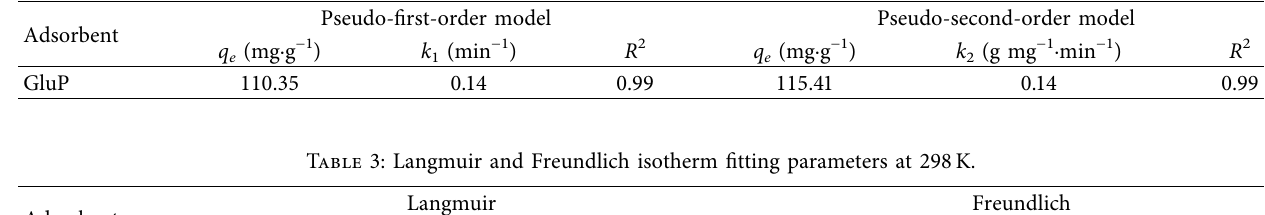
Table 2: Kinetic parameters for the adsorption of CR on GluP at 298K.